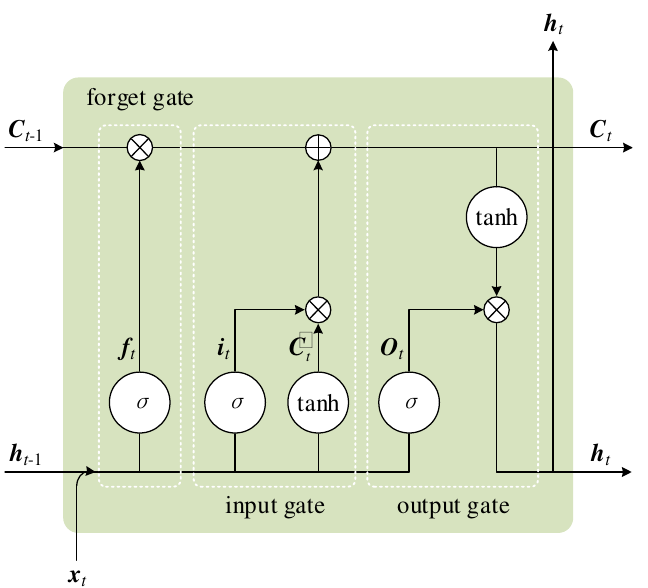
Figure 5. The basic structure of the LSTM